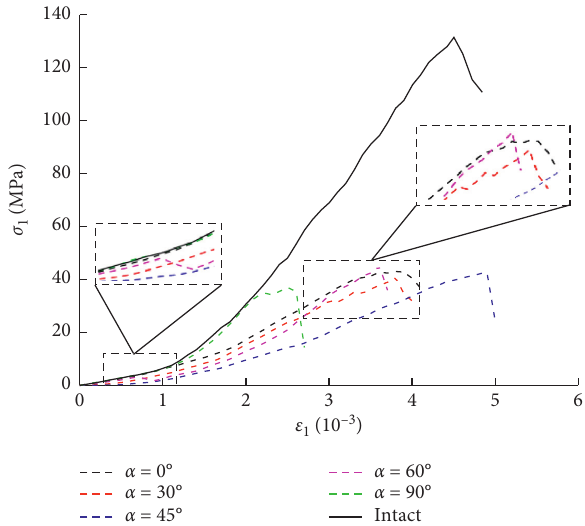
Figure 5: Stress-strain curves of the granite